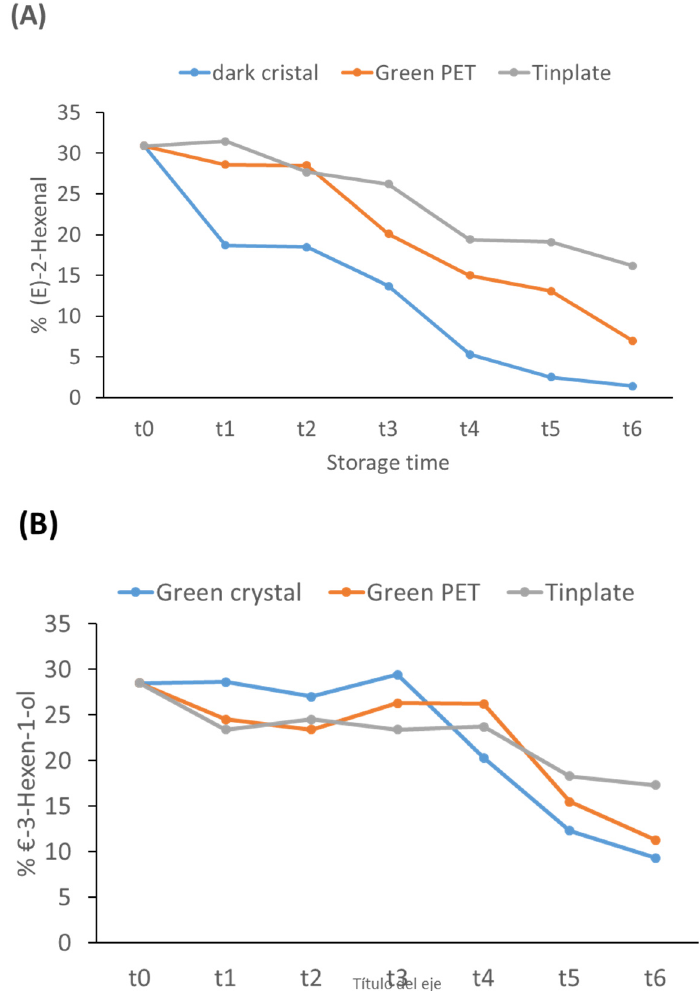
Figure 3. Evolution of the most prominent VOCs during the storage time. ( A ) (E)-2-Hexenal; ( B ) (E)-3-Hexen-1-ol.